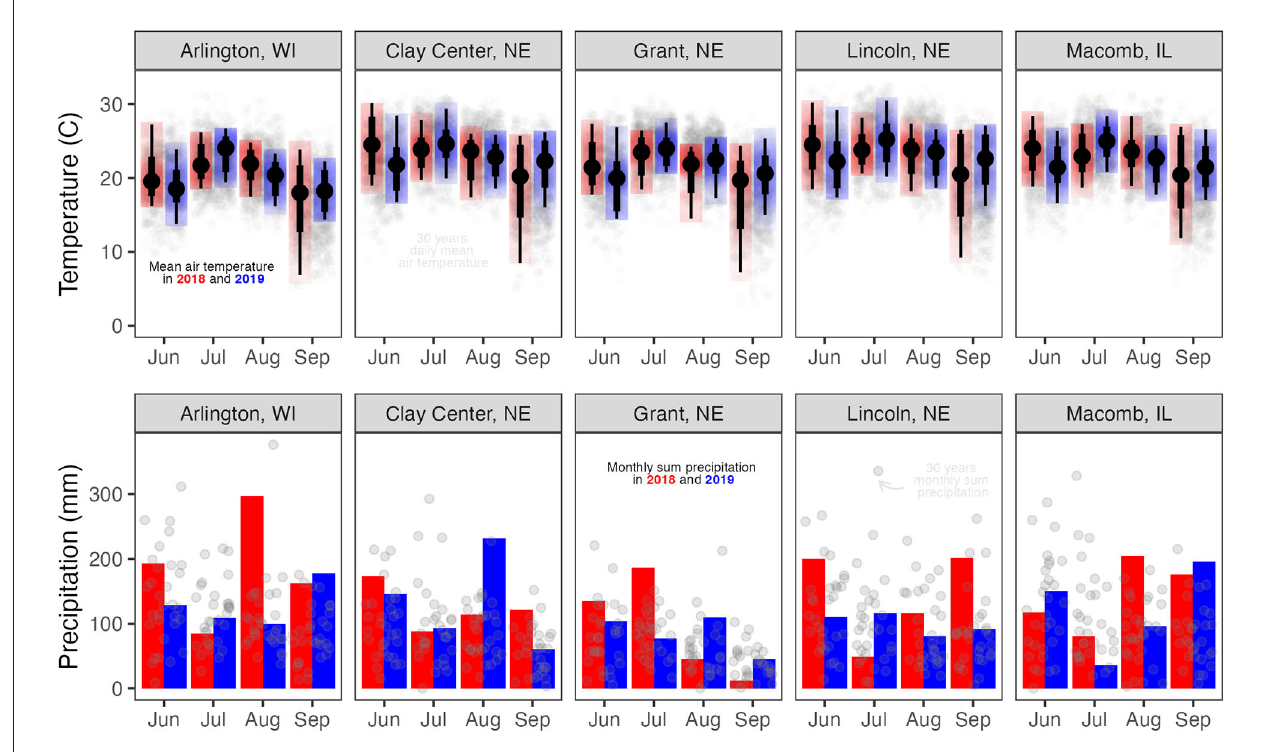
FIGURE 3 | Palmer amaranth adaptation study layout of a plant cohort timing in bareground, corn, and soybean. Twenty-four Palmer amaranth plants were placed 76.2 cm apart in each field experimental unit.